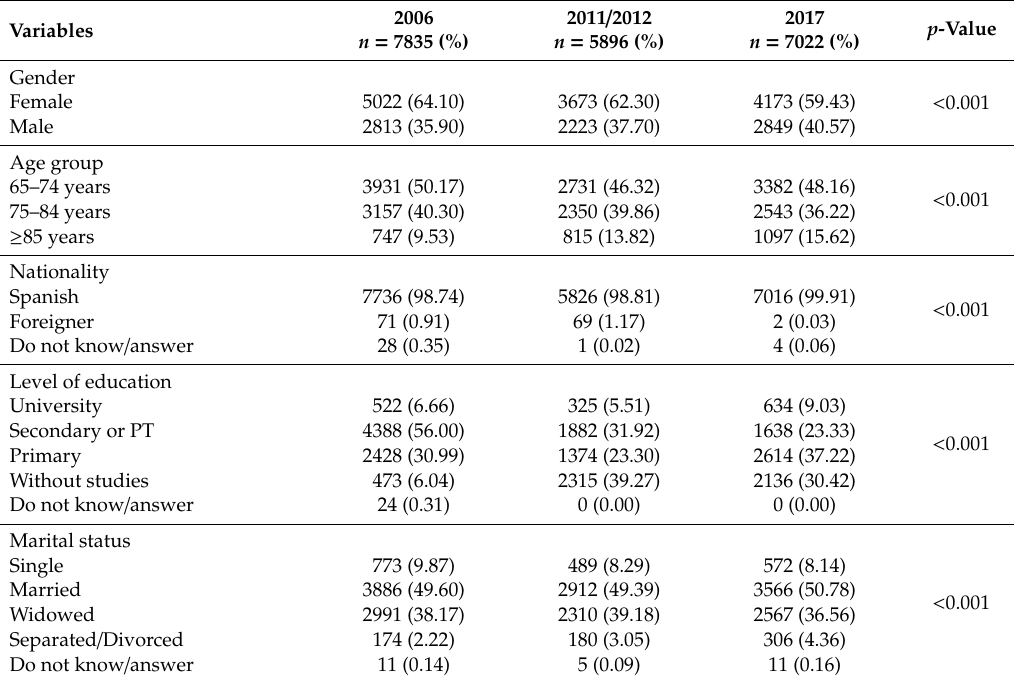
Table 1. Sociodemographic and health-related characteristics of people aged ≥ 65 years in Spain. Spanish National Health Surveys